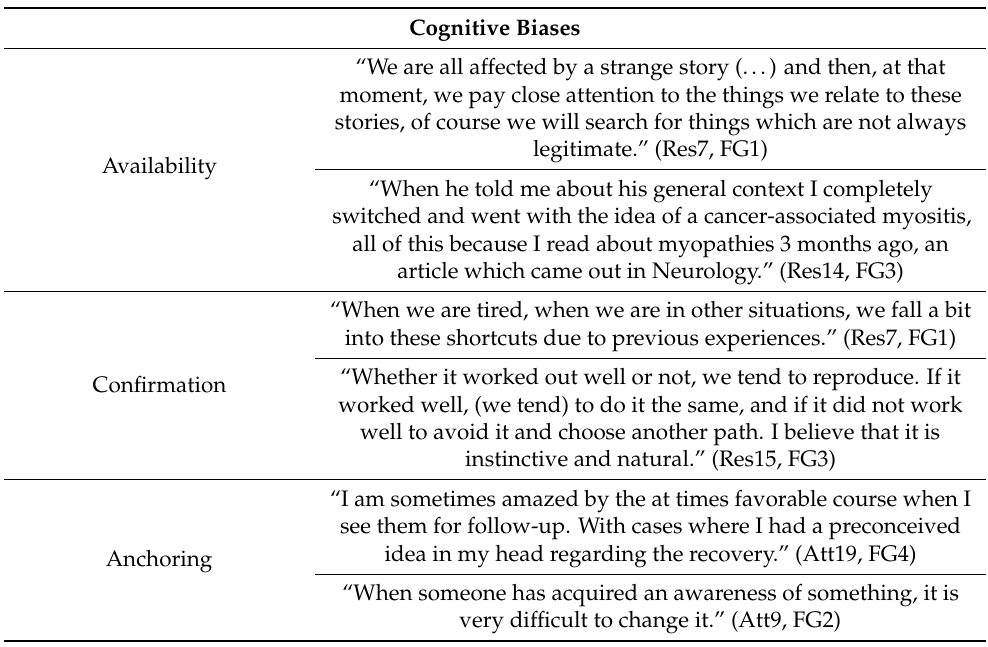
Table 5. Cognitive